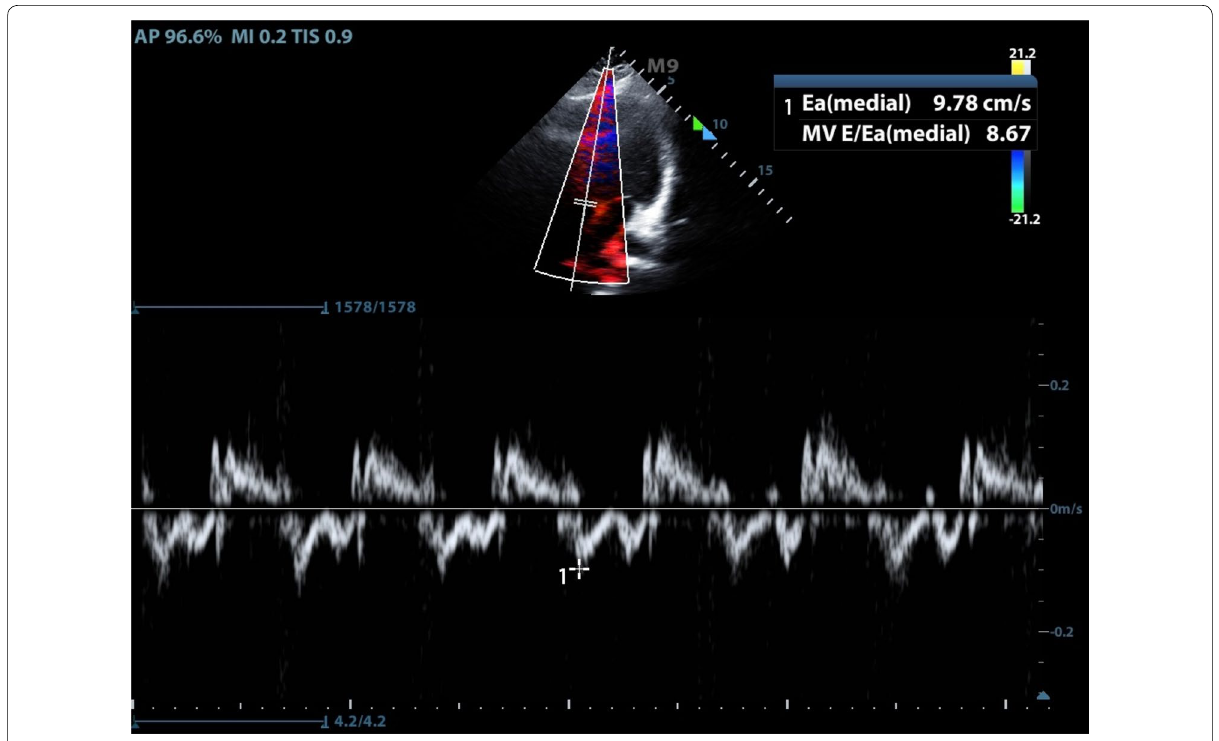
Fig. 4 Measurement of mitral valve E’ in apical view